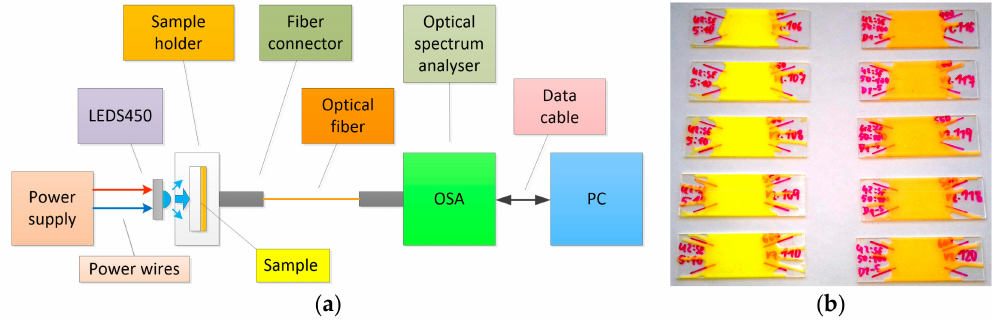
Figure 3. Diagram of assembly for measuring samples 1–10 ( a ), photographs of measured samples 1–10 ( b ).